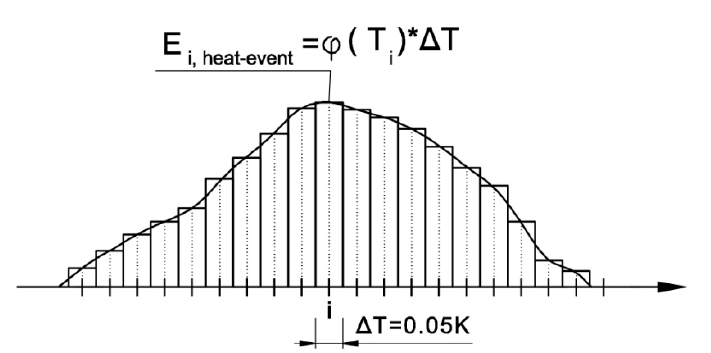
Figure 7. Schematic of the breakdown of the thermal capacity ( ϕ ( T )) signal into segments 0.05 K in wide with the amount of energy in each segment E i,heat-event .